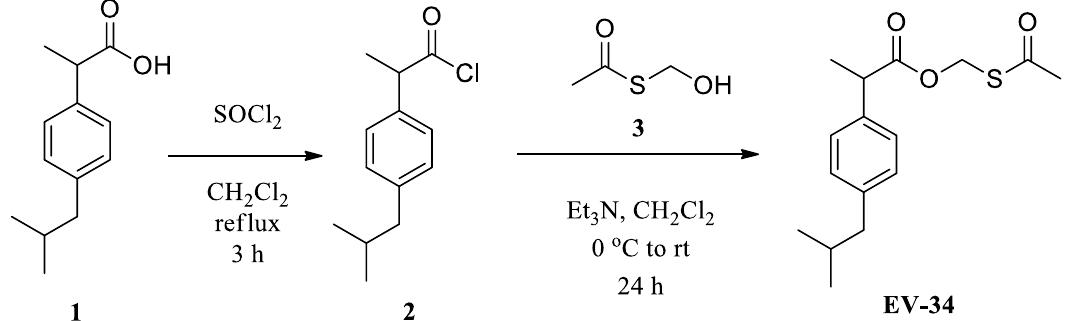
Figure 1. Synthesis of the new H 2 S-releasing derivative of ibuprofen.